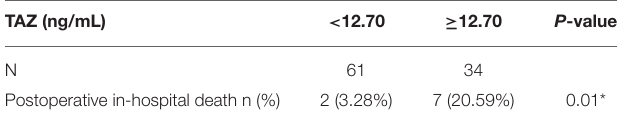
TABLE 4 | Postoperative outcome for the TAZ < 12.70ng/ml group and TAZ ≥ 12.70ng/ml group. TAZ